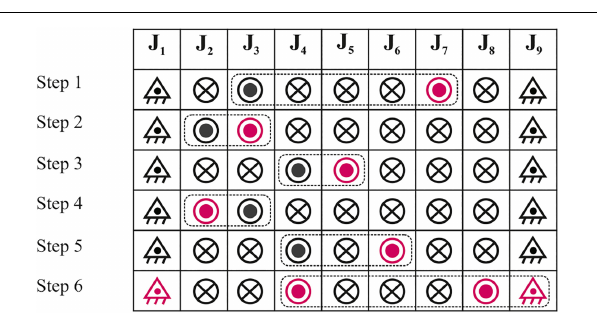
FIGURE 9 | The optimum solution of a motion